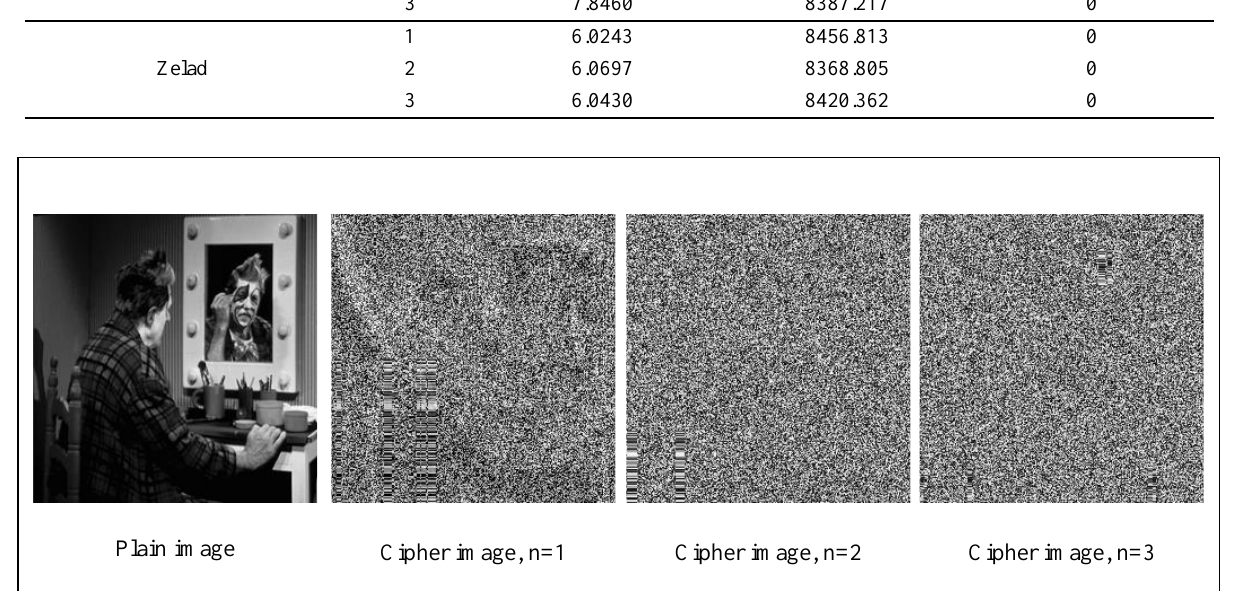
Figure 6. "Clown.png" cipher images according to the proposed method The nonzero MSE for the decipher images indicates that there is a loss in some decipher images in case of n=1. Fig. 7 shows the cipher and decipher images in the three cases of n.